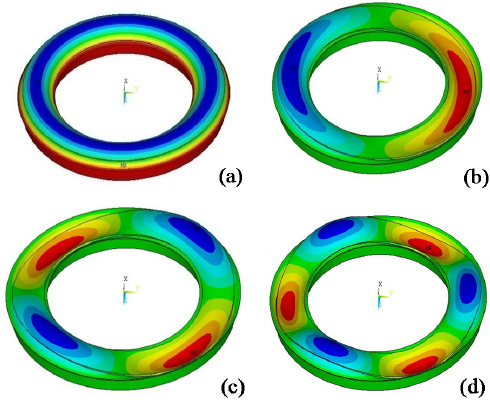
Figure 4. The first four modes of vibration.